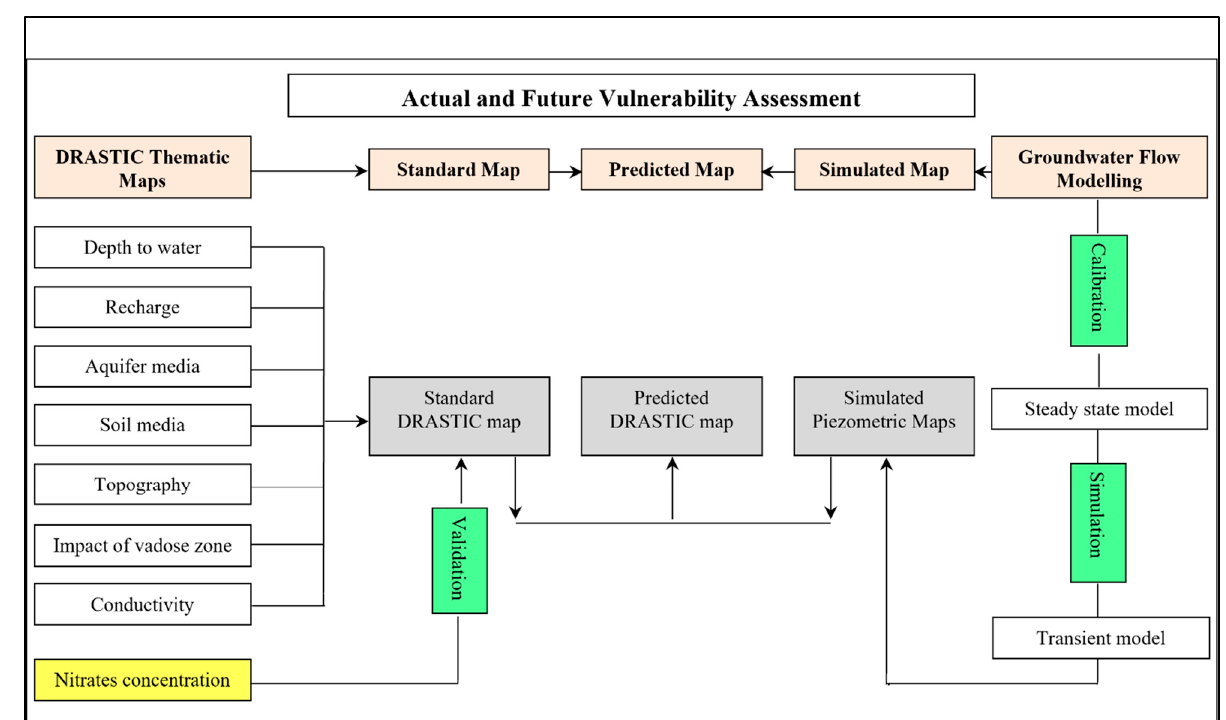
Figure 3. Methodological steps adopted for the mapping of groundwater vulnerability in the Tebessa-Morsott alluvial plain.